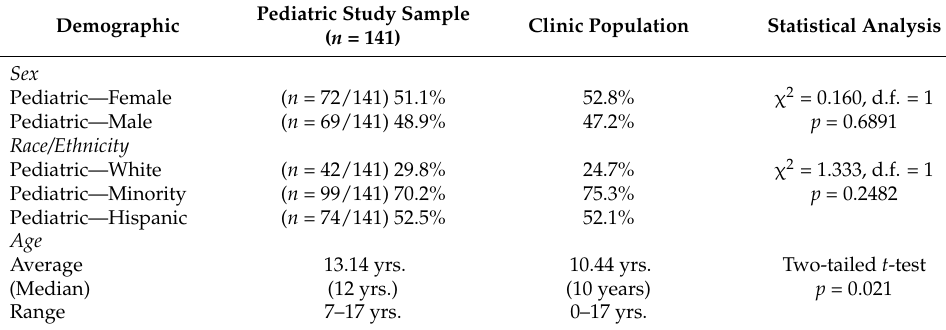
Table 1. Demographic analysis of pediatric study samples.